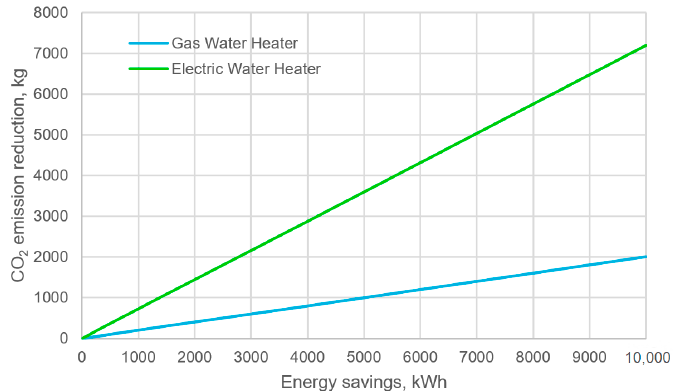
Figure 5. CO 2 emission reduction resulting from the installation of shower heat exchangers.